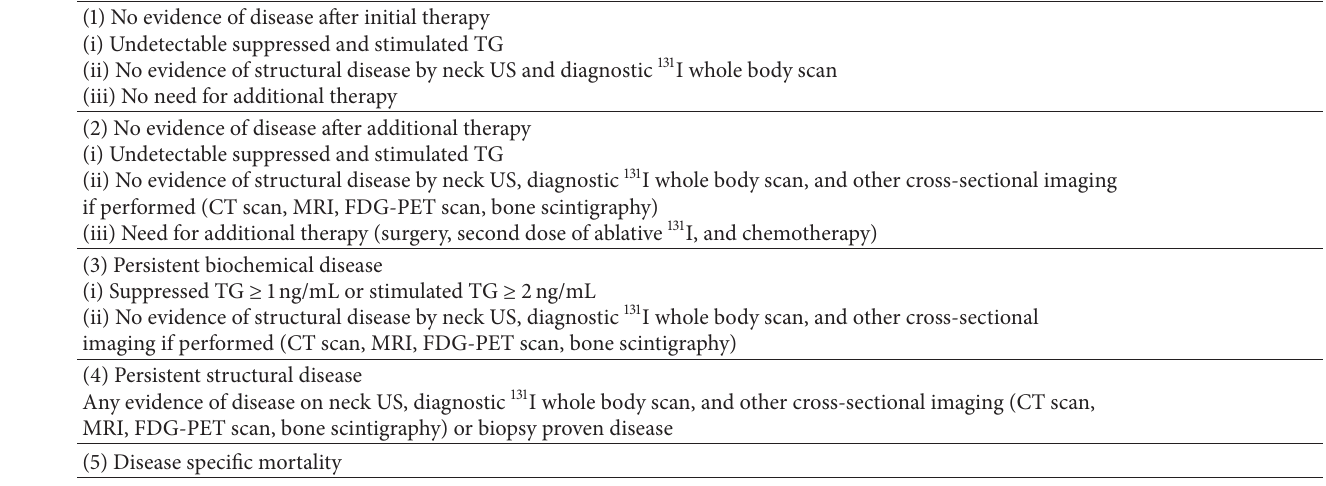
Table 1: Clinical outcomes at the end of follow-up period.